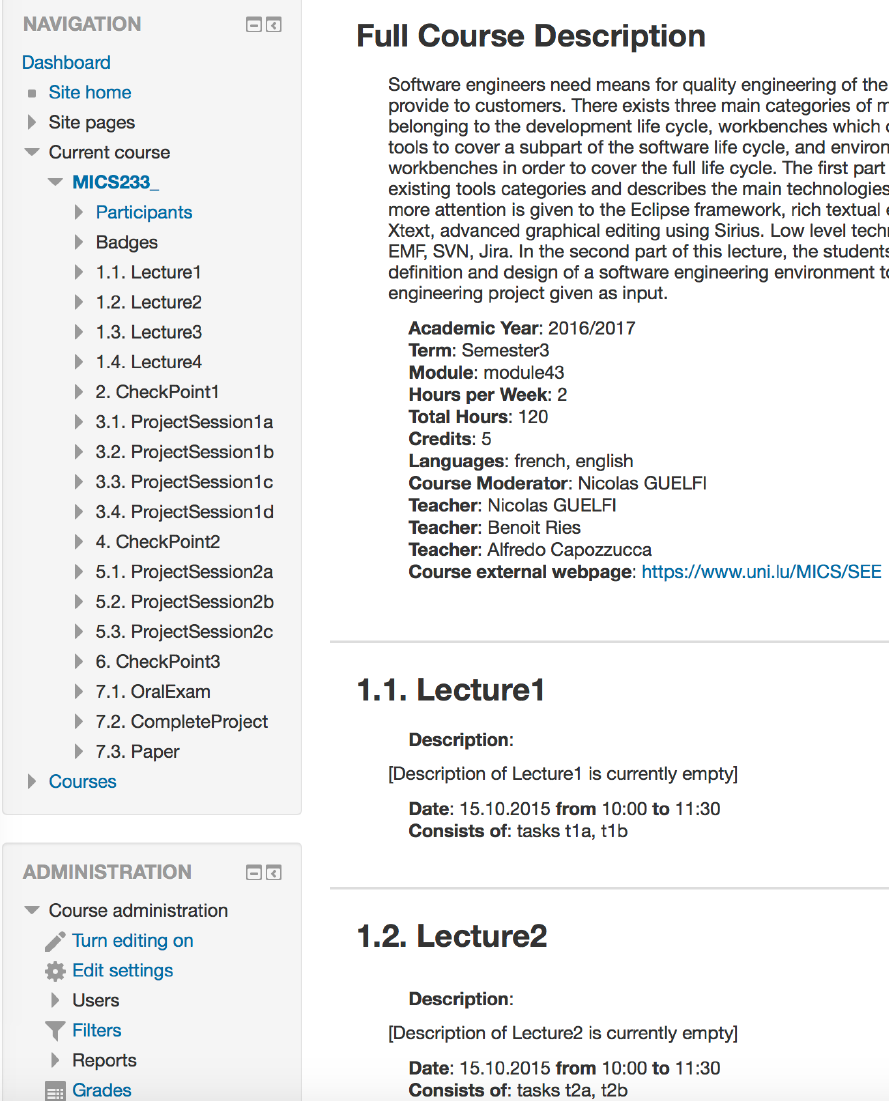
Figure 7. Generated course in